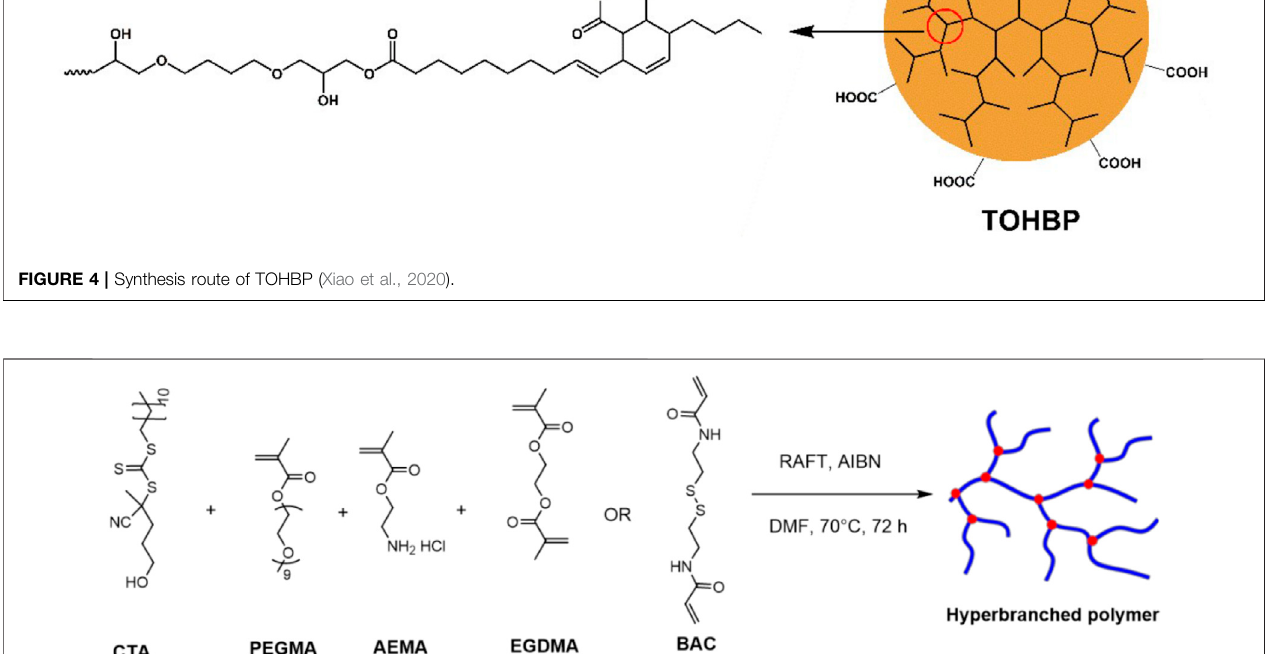
Frontiers in Energy Research |